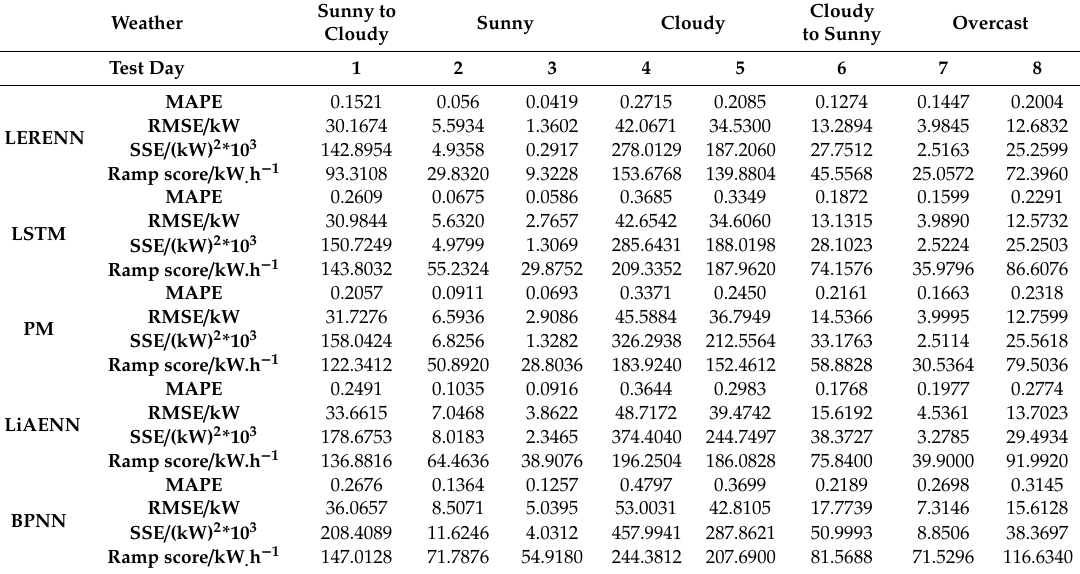
Table 4. Comparison of single-step prediction errors among di ff erent models under di ff erent weather conditions.